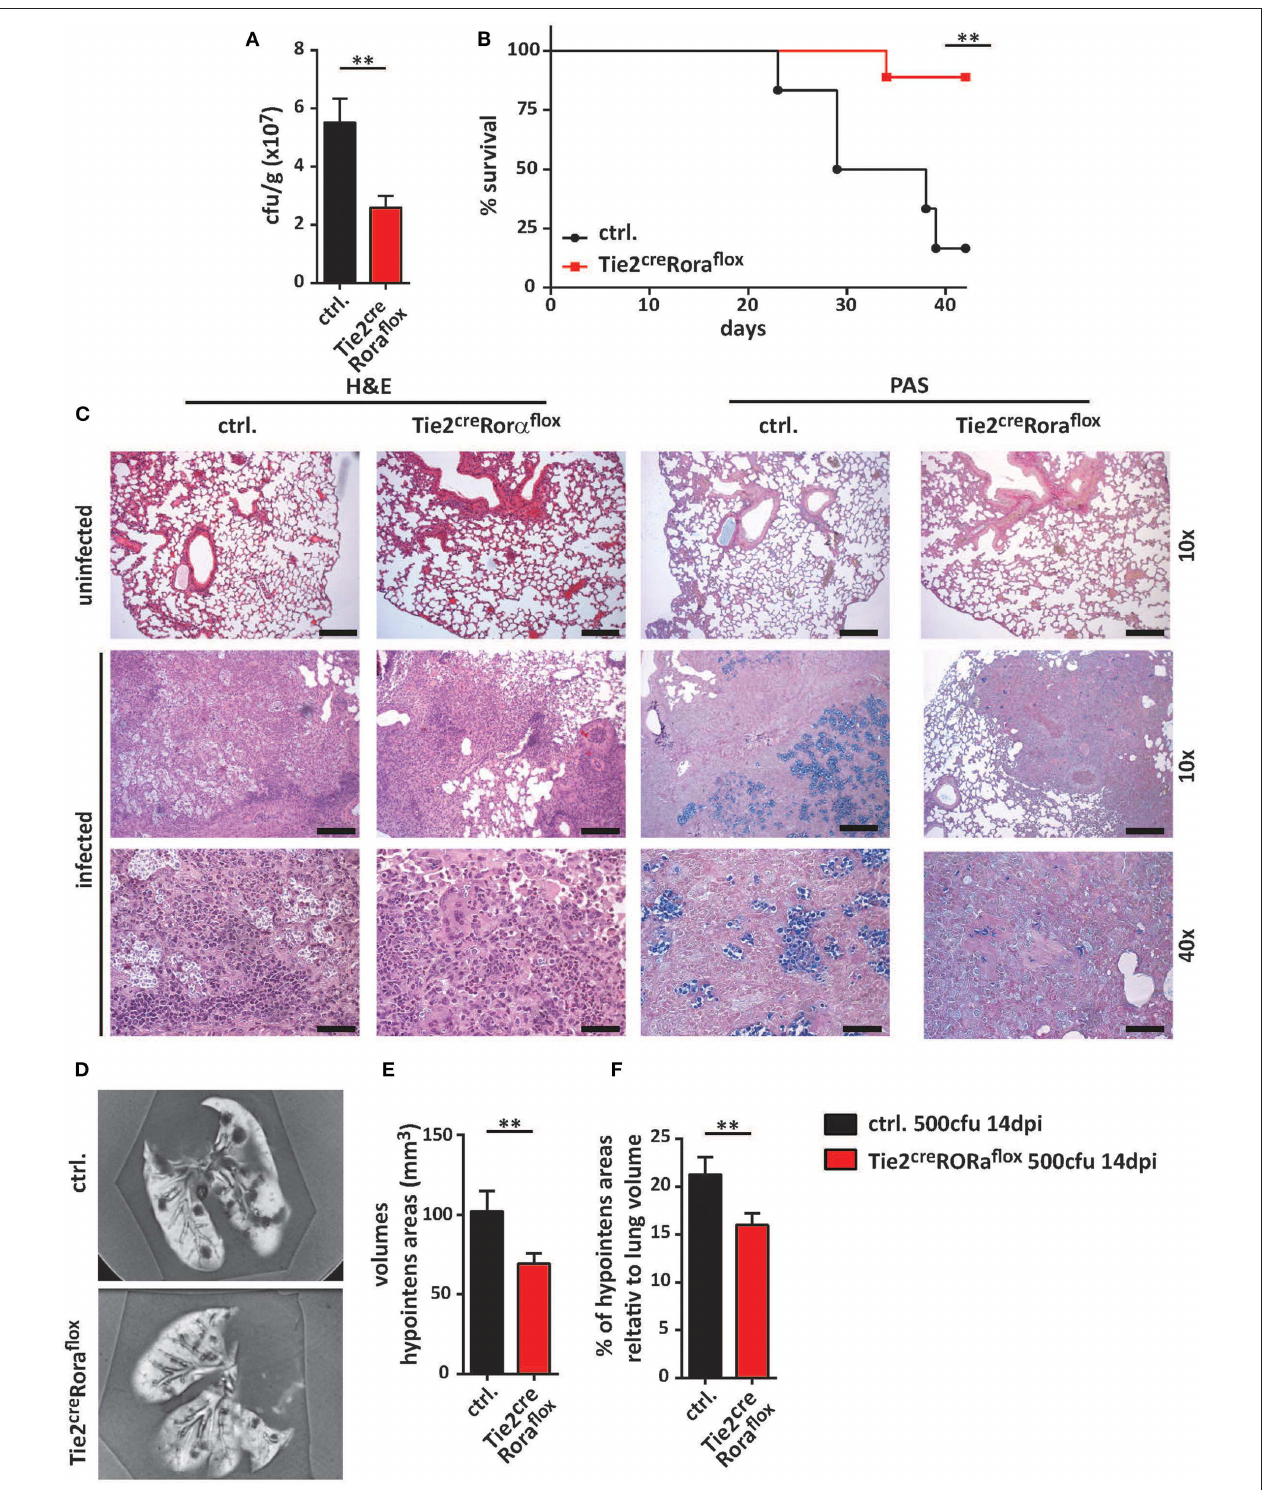
FIGURE 2 | Improved fungal control in ILC2-deficient mice. (A–F) Control and Tie2 cre Rora flox mice were intranasally infected with 500 cfu of C. neoformans and sacrificed after 2 weeks. (A) Pulmonary fungal burden of control ( n = 13) and Tie2 cre Rora flox mice ( n = 17) was determined by plating serial dilutions of organ homogenates on SAB-Agar. (B) Animal fitness was judged over the indicated time course and illustrated as % survival. (C) Representative H&E and PAS stainings of